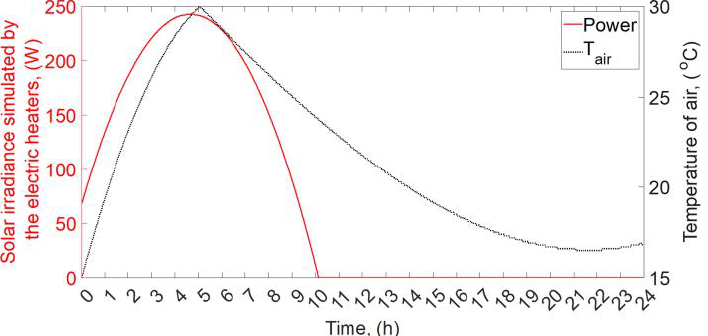
Figure 4. Power of the electric heaters (simulating solar irradiance) and temperature of air for simulations.